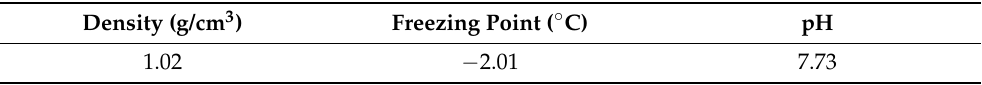
Table 7. Physical and chemical properties of water-based annular protective